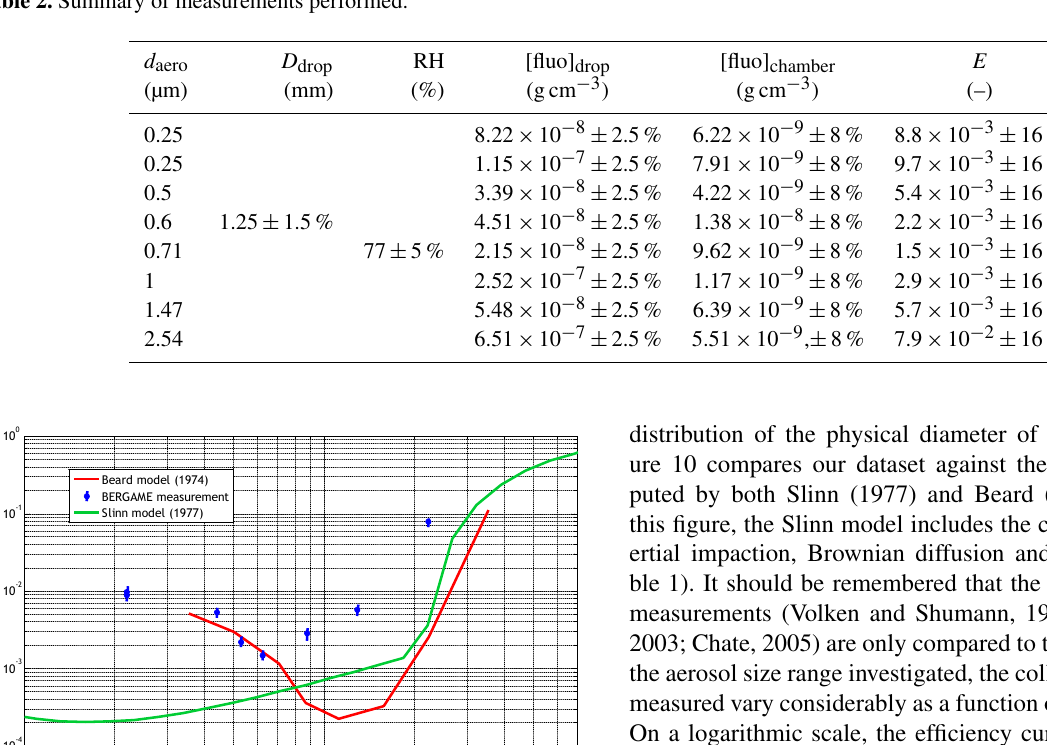
Table 2. Summary of measurements performed.